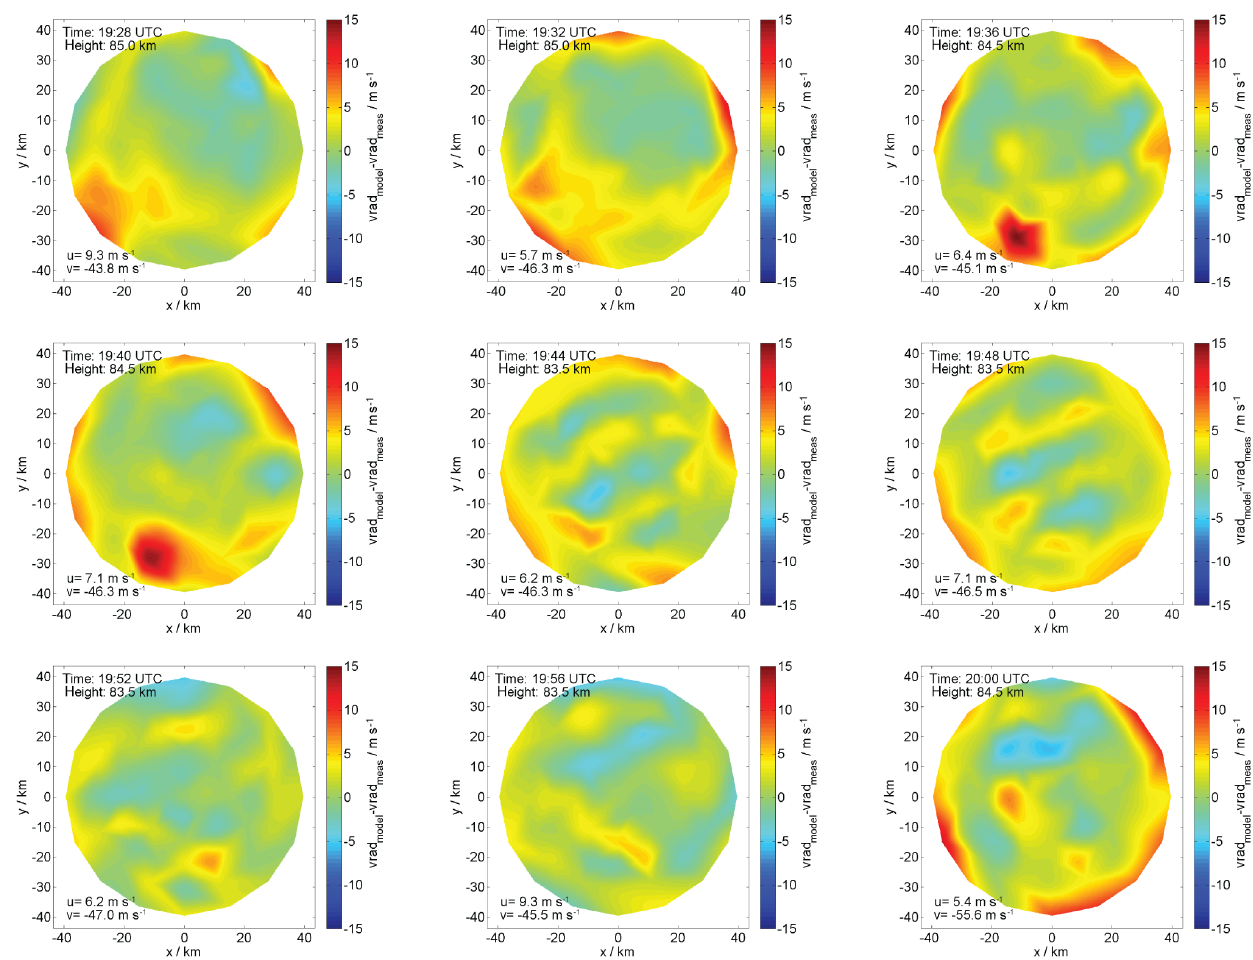
Figure 9. Sequence of nine successive radial velocity residual images measured on 30 June